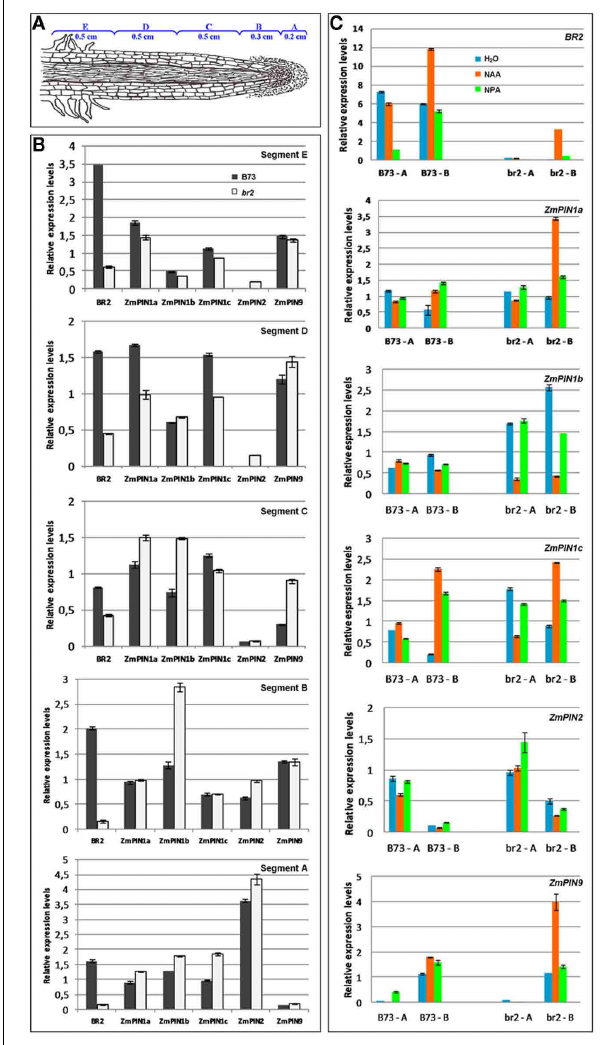
FIGURE 6 | br2/abcb1 mutation and drug applications alter auxin transporter expression levels. Quantitative RT-PCR analysis of ZmABCB1 / BR2 , ZmPIN1a , ZmPIN1b , ZmPIN1c , ZmPIN2 , and ZmPIN9 was performed in root segments (from A–E) of B73 line and br2 mutant under different treatments.The average value from three replicates and two biological samples was estimated by the generation of standard curves for each gene. Expression levels of each auxin transporter gene were normalized to GAPC2 transcript quantities. Standard deviation bars are indicated in the diagram. (A) Schematic representation of a maize root indicating the different segments used in expression analysis. (B) Quantitative RT-PCR expression analysis of auxin transporters in B73 and br2 mutant roots.The altered auxin shootward transport in the mutant root results in different expression levels of PIN mRNAs. (C) Quantitative RT-PCR expression analysis of auxin transporters after NAA and NPA application in B73 and br2 mutant roots. Applications of 50 μ M NAA and 50 μ M NPA to young seedlings result in a tissue-specific modulation of PIN transcripts.The most dramatic effects are observable in the mutant